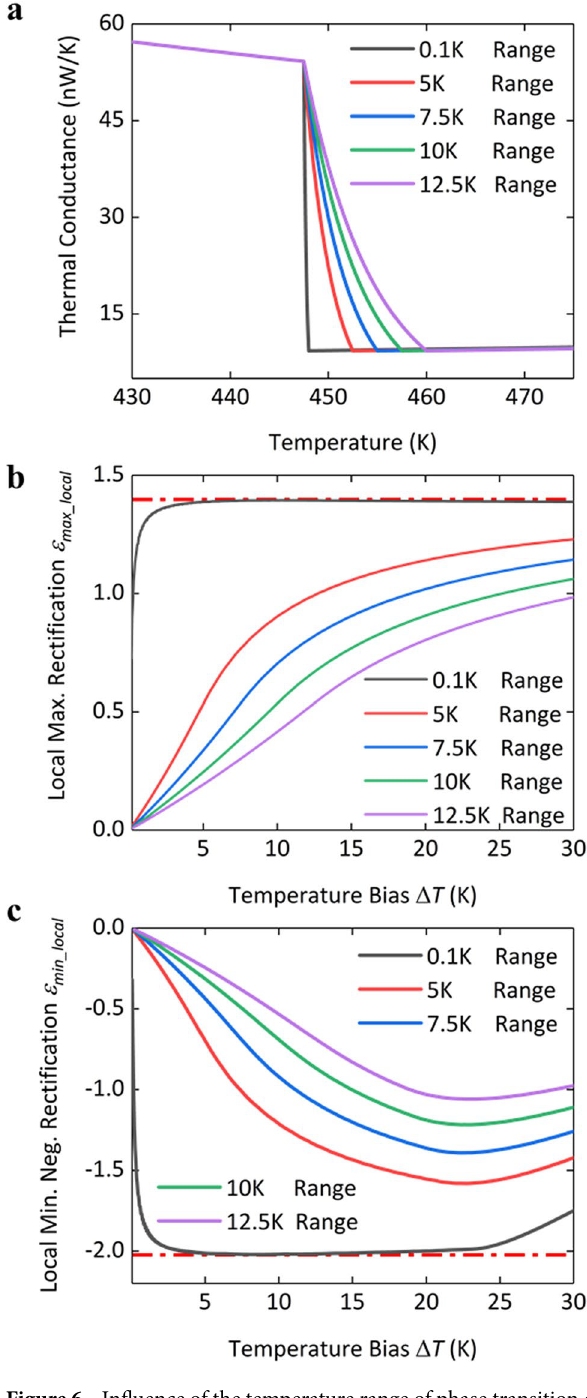
Figure 6. Influence of the temperature range of phase transition on rectification. ( a ) Thermal conductance versus temperature of the pristine segment with a series of temperature ranges of phase transition. ( b ) Local maximum rectification ε max_local at certain temperature biases within the working temperature T 1 range of 435–455 K of HI-P junctions. The red dash-dotted line shows the maximum rectification indicated by the step- function model. The length fraction of irradiation is 5%. ( c ) The local minimum negative rectification ε min_local at certain temperature biases within the working temperature T 1 range of 420–455 K of LI-P junctions with the different phase transition temperature ranges of the LI segment. The red dash-dotted line shows the minimum negative rectification indicated by the step-function model. The length fraction of irradiation is